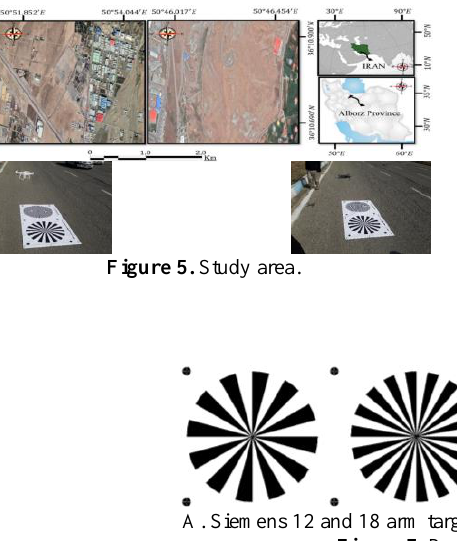
Figure 7. Designed Siemens